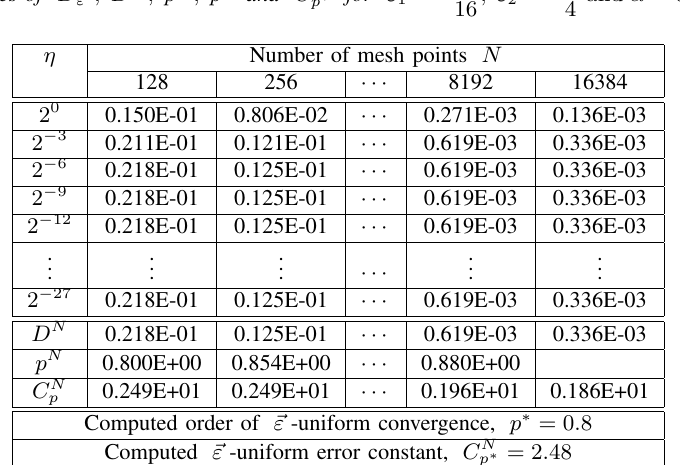
Values of D N ε , D N , p N , p ∗ and C N